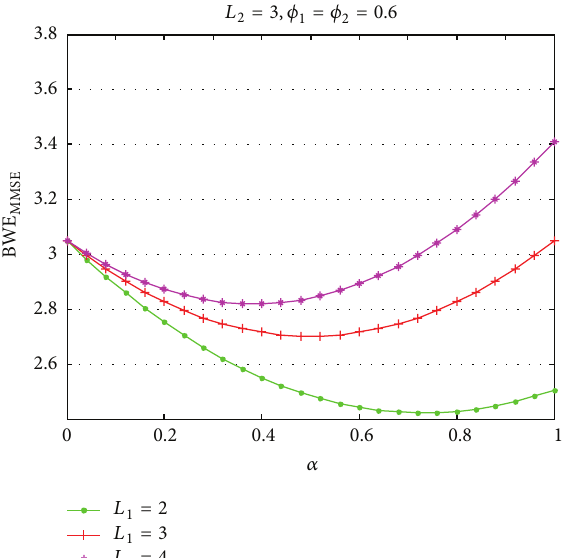
Figure 5: Impact of 𝜙 1 on bullwhip effect for different 𝛼 under the MA.